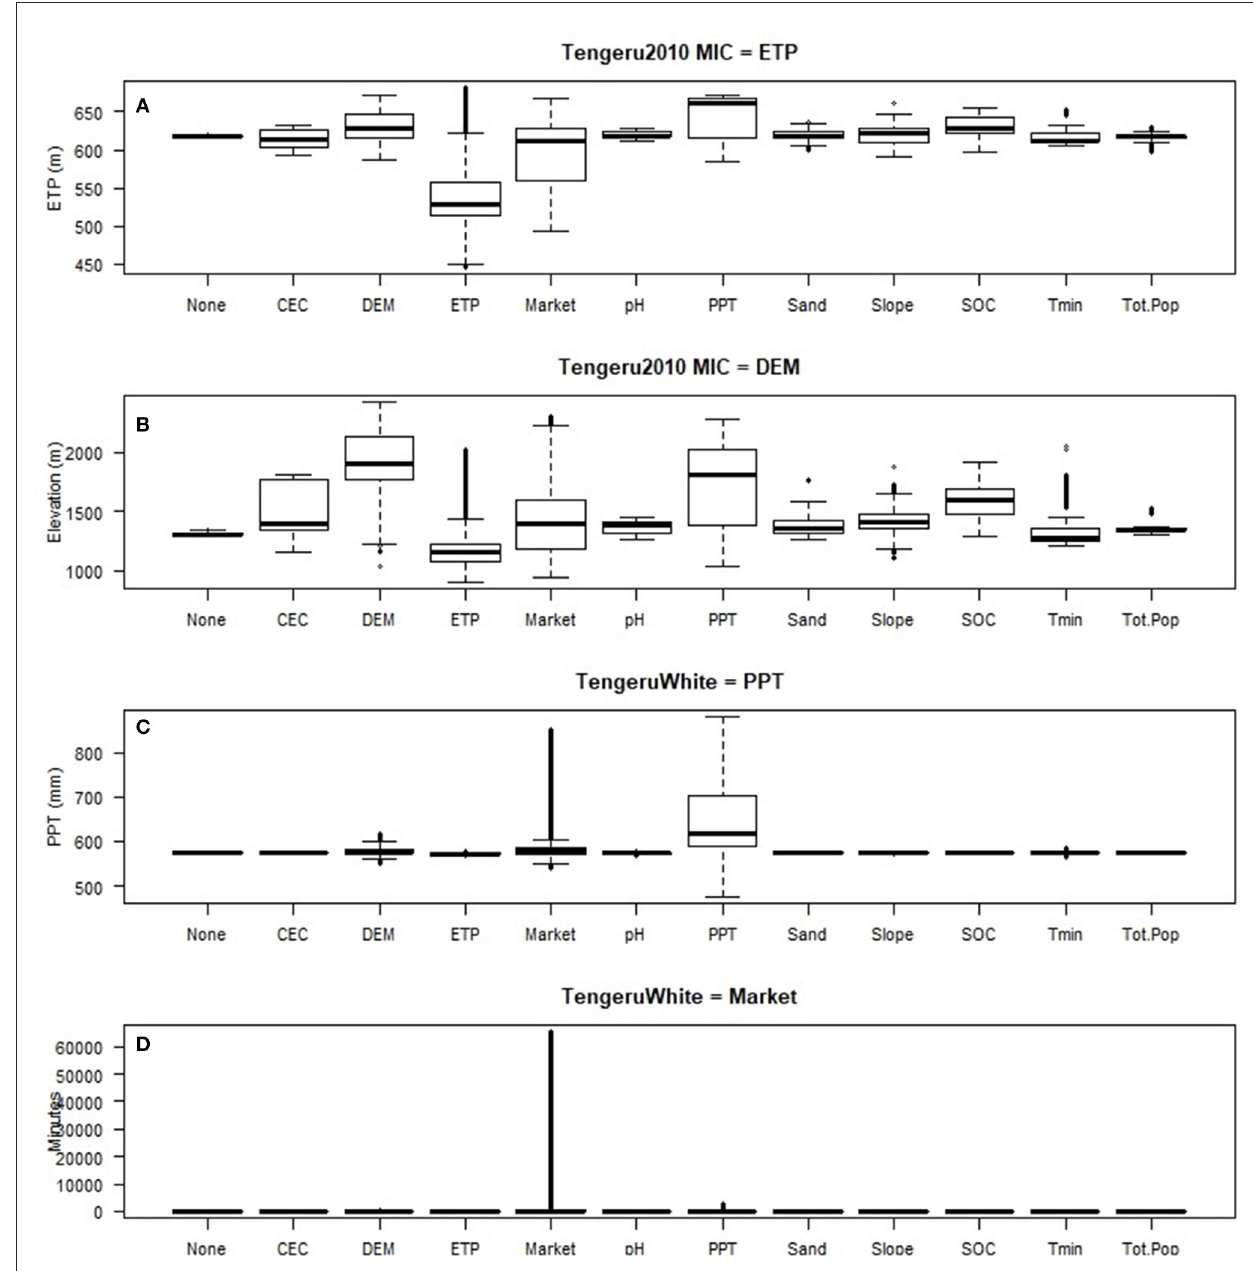
FIGURE8 Boxplot of some of the most influential covariates (MIC) for the two vegetable cultivars in different Babati district zones. The MIC’s for Tengeru 2010 are (A) evapotranspiration (ETP) and (B) elevation (DEM). MIC for Tengeru White eggplant are (C) precipitation (PPT) and (D) market access. The zone where none of the covariate was limiting represented the reference trial